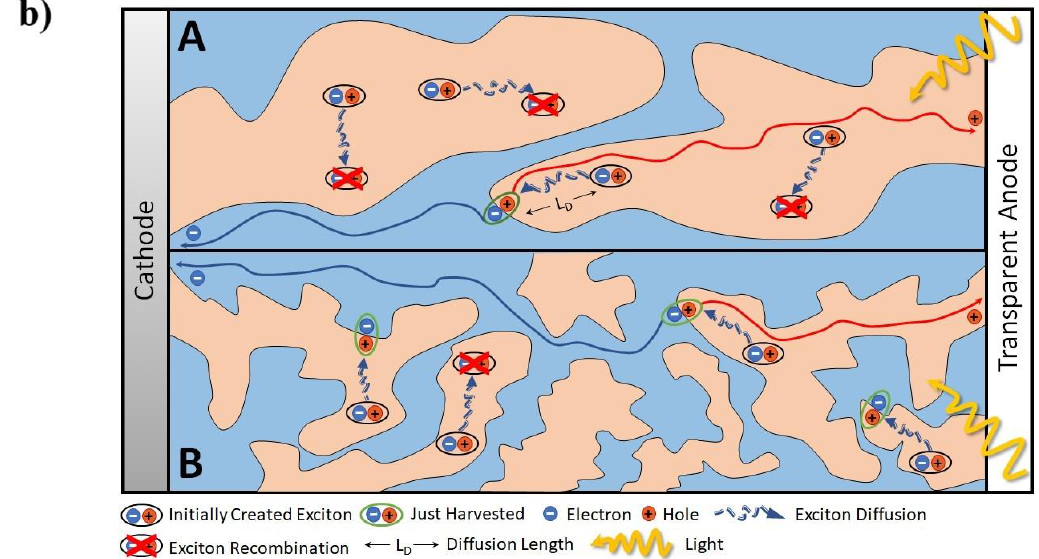
Figure 3. ( a ) Typical band diagram for a donor:acceptor BHJ in organic solar cells; ( b ) Photocurrent generation processes in two BHJs with very different morphologies: a bad morphology (A) and a good morphology (B).